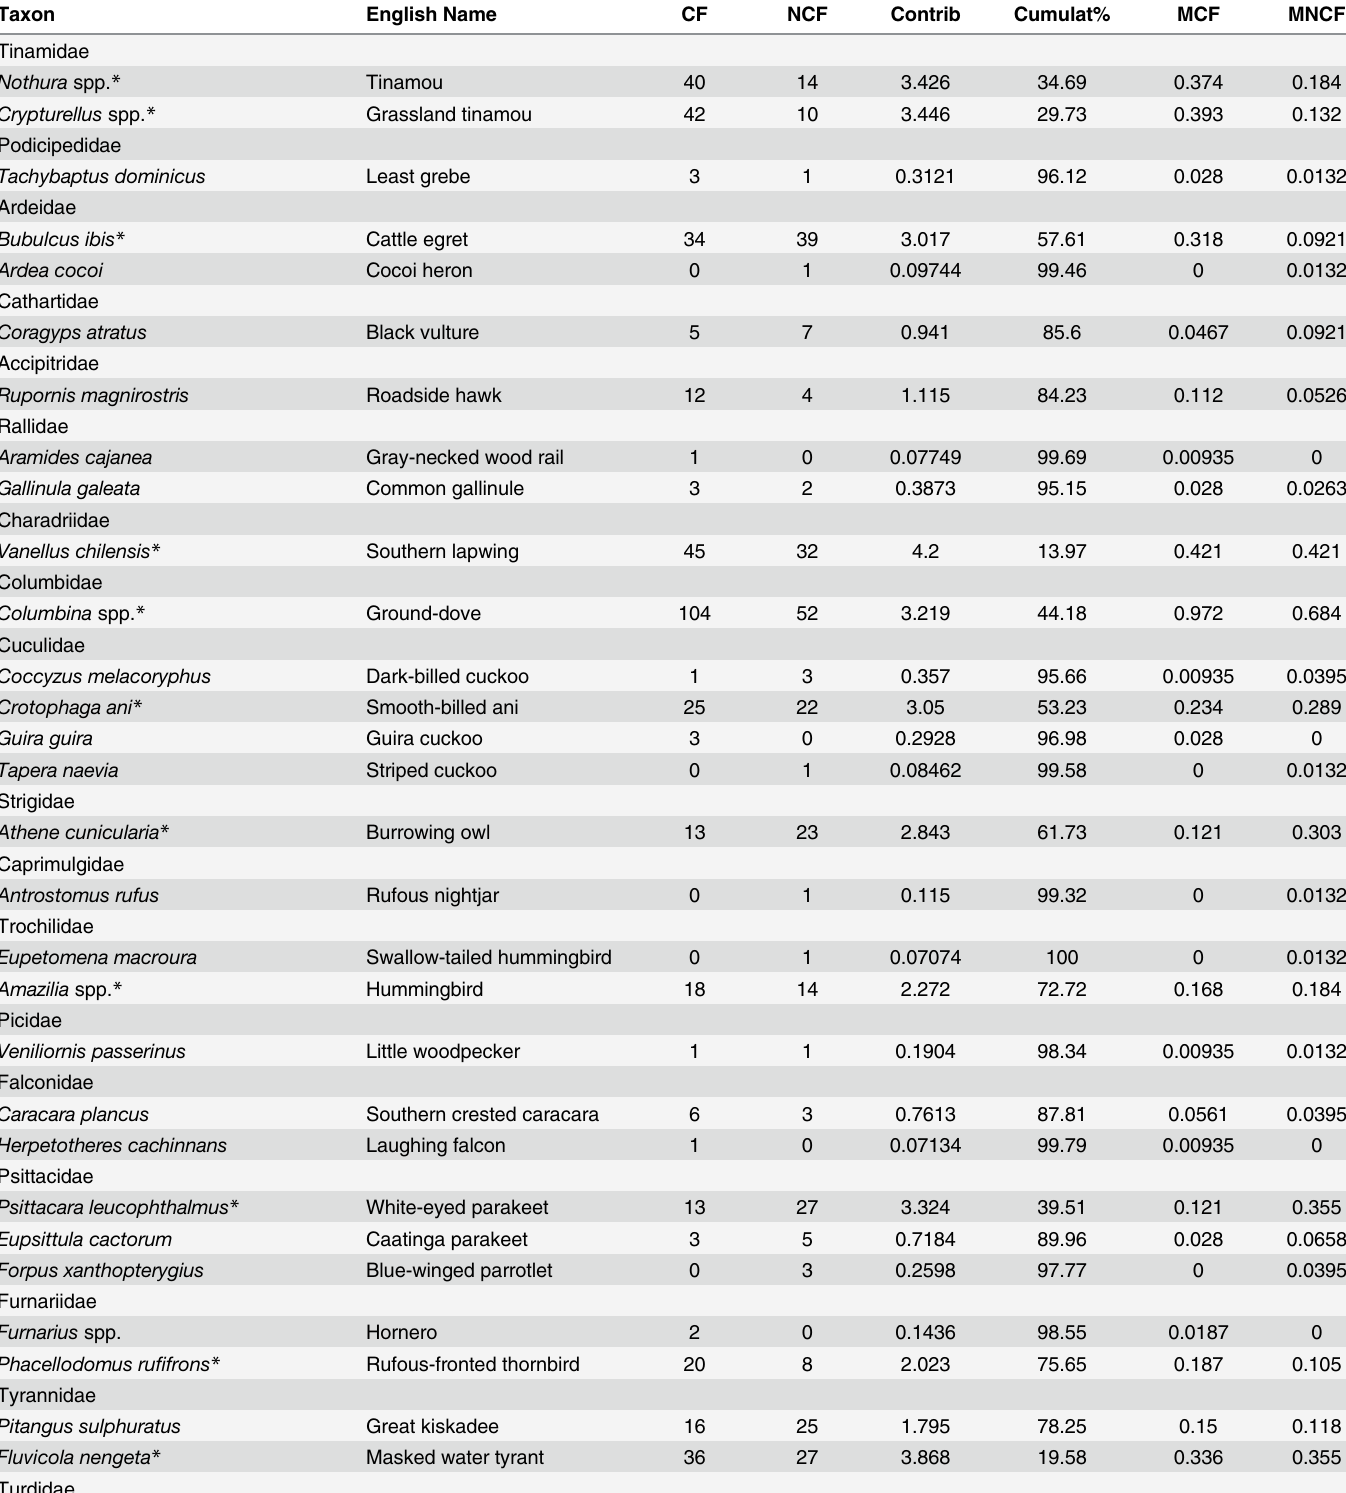
Table 1. Bird species reported by conventional farmers and non-conventional farmers from Jupi, Pernambuco, northeastern